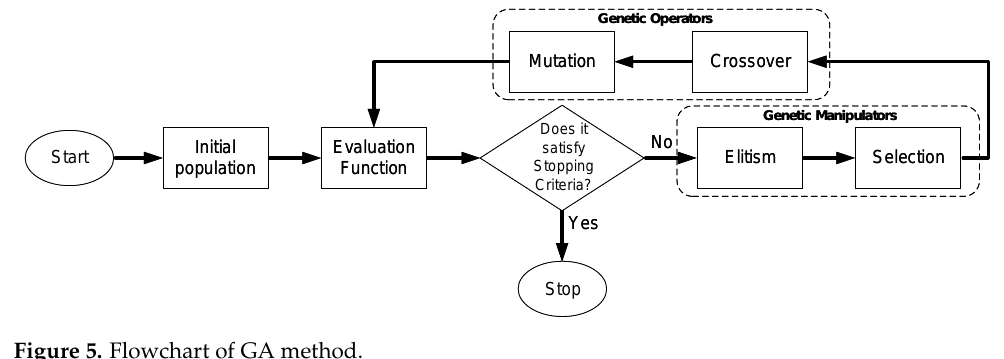
Figure 5. Flowchart of GA